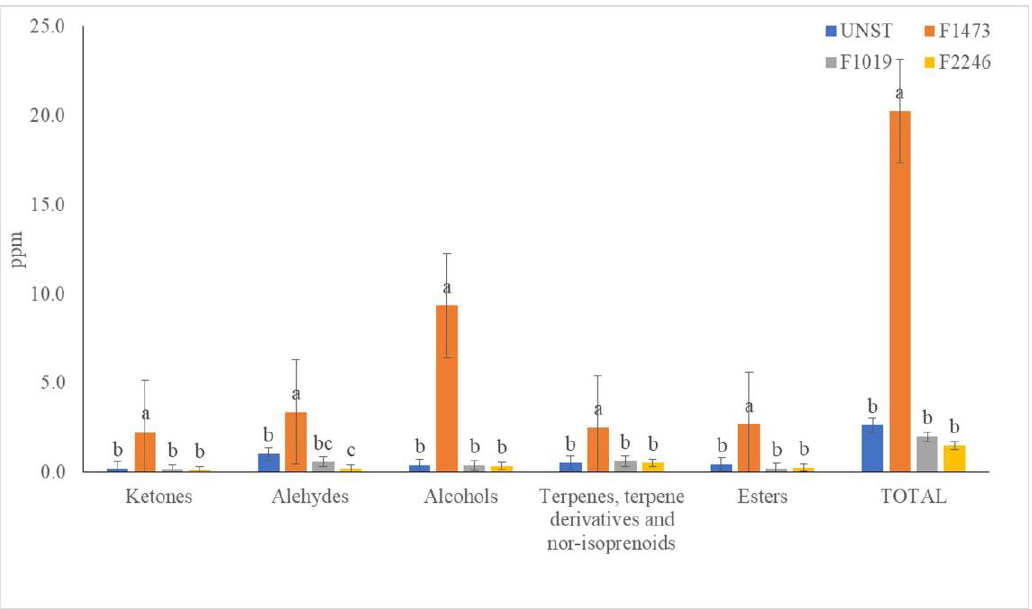
Figure 1. Effect of lactic acid bacteria (LAB) fermentation on volatile composition of apple pomace. One-way analysis of variance (ANOVA), Tukey’s test ( p ≤ 0.05). letters a–c: mark significant di ff erences / analogies among the samples. UNST: unstarted apple pomace ( ); F1473: apple pomace fermented with Lactobacillus rhamnosus 1473 ( ); F1019: apple pomace fermented with Lactobacillus rhamnosus 1019 ( ); F2246: apple pomace fermented with Lactobacillus casei 2246 ( ).